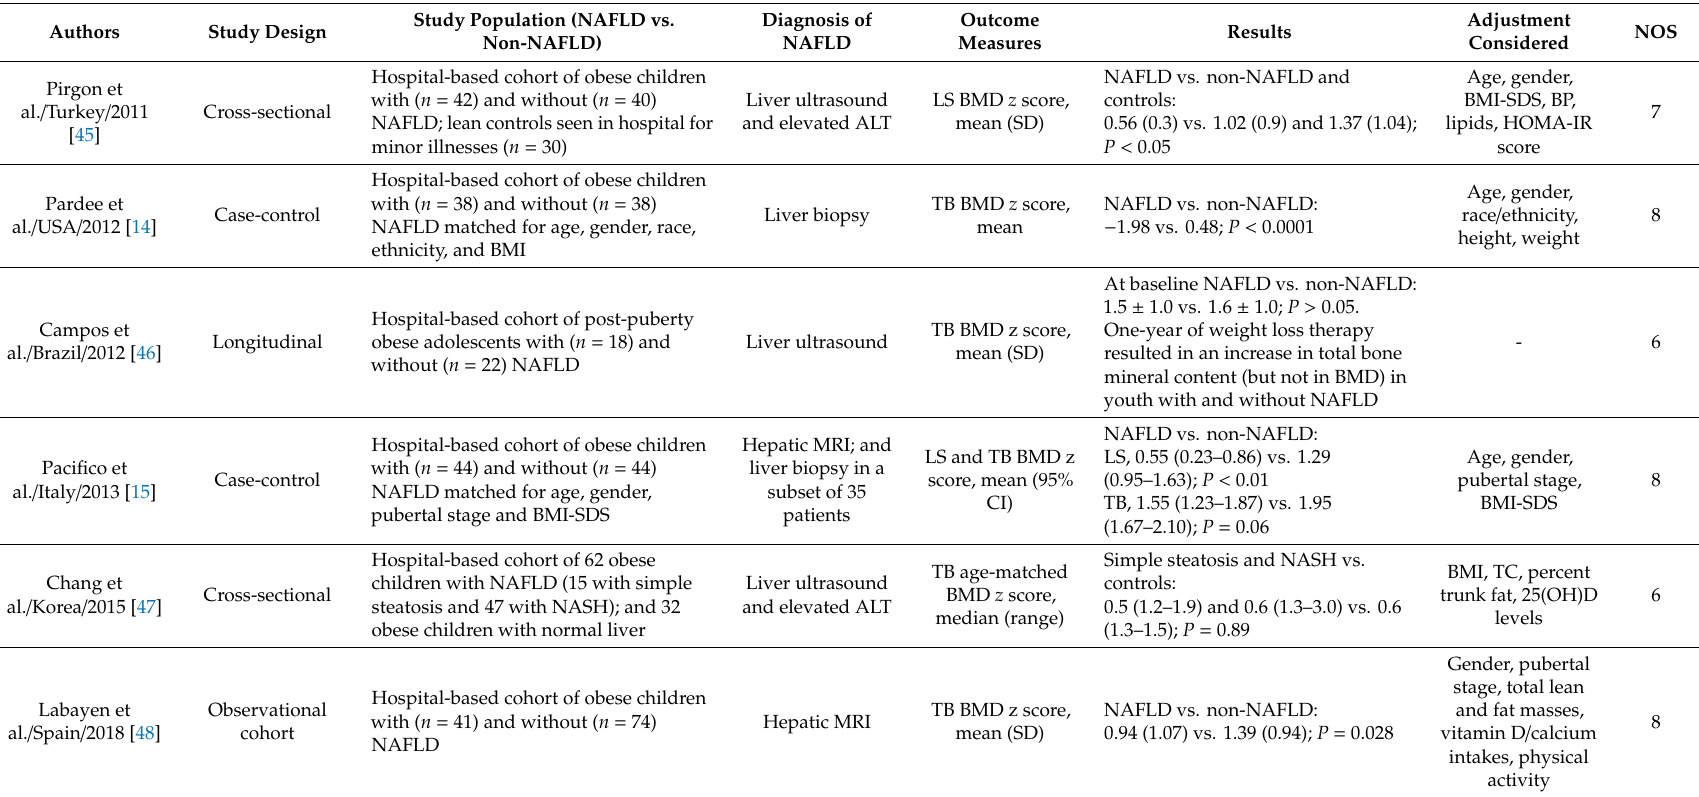
Table 4. Study characteristics for nonalcoholic fatty liver disease and low bone mineral